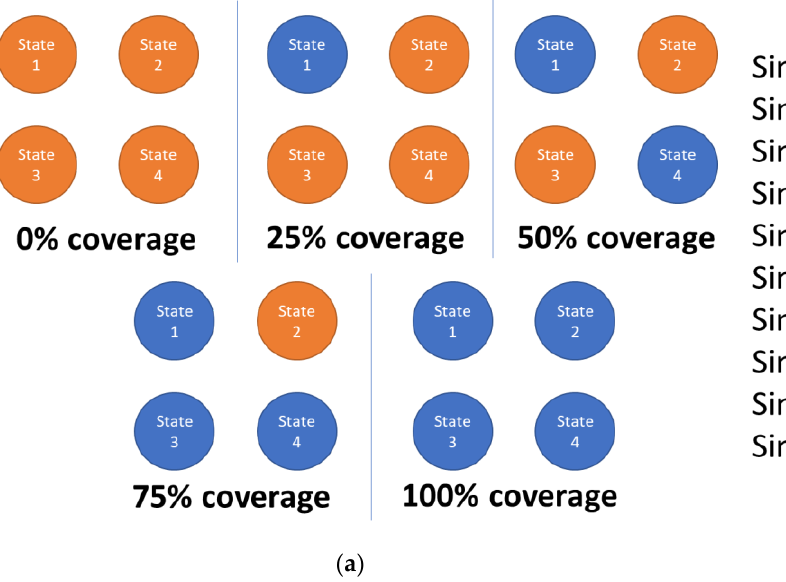
Figure 1. ( a ) Evolution of state coverage for an FSM; ( b ) list of states addressed by the FSM during each simulation.